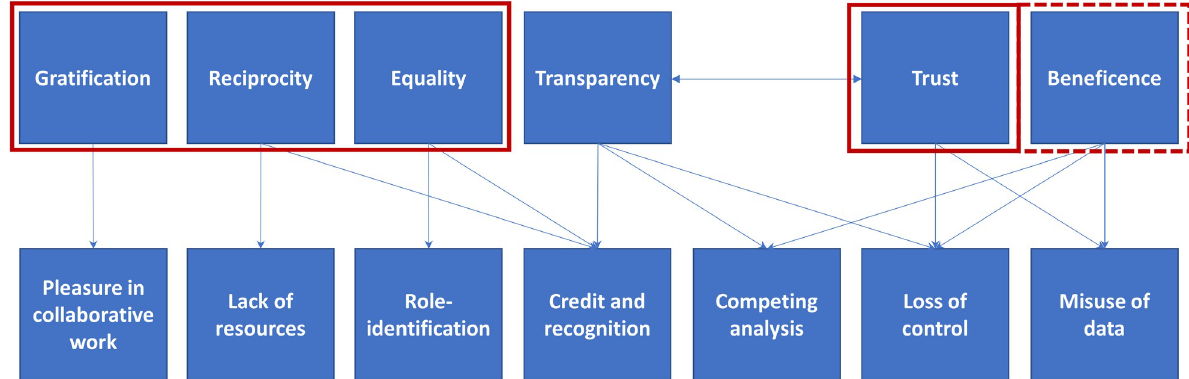
Fig 2. Core values and principles underlying factors influencing data sharing. Values that underpin data sharing were identified from arguments in the interview data. No connections were coded where arguments were absent but where connections could theoretically exist. Competing analysis was coded as a separate category due to its connections with various values. Socio-cultural factors were split into role-identification and enjoyment in collaborative work. Values which push researchers towards collaboration are framed with red boxes.